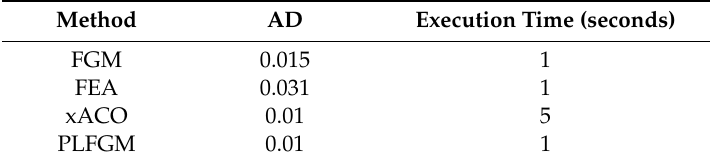
Table 5. Performances of various methods.